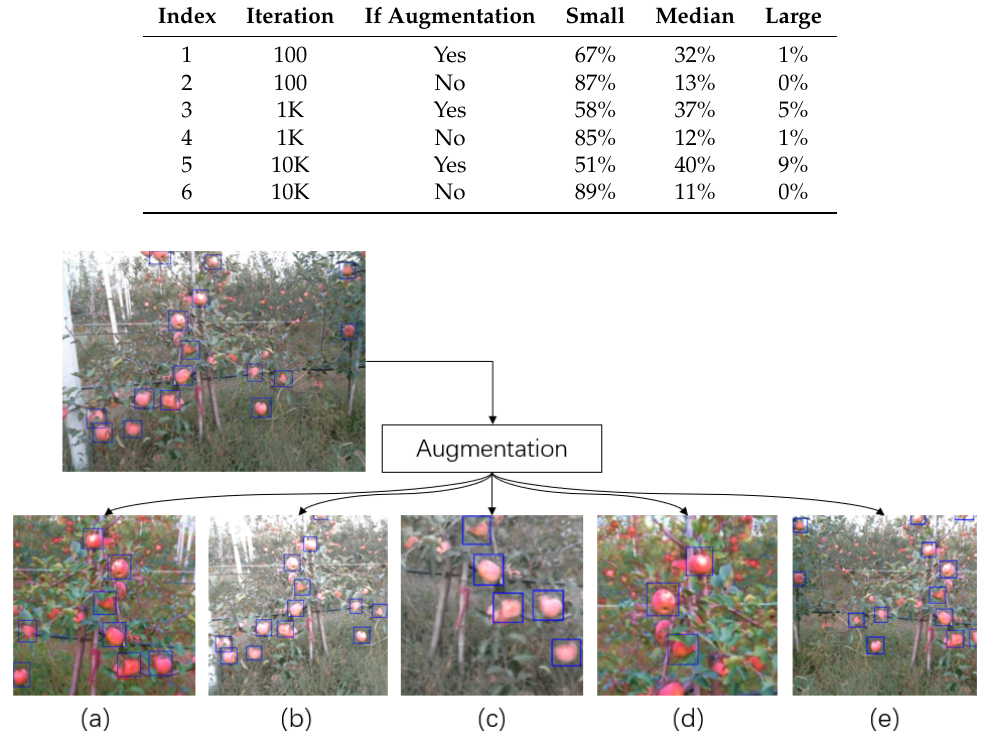
Figure 8. Examples of augmentation method applied in the network training using: ( a ) crop, flip and saturation adjustment; ( b ) brightness and contrast adjustment; ( c ) crop and flip; ( d ) crop and saturation; and ( e )